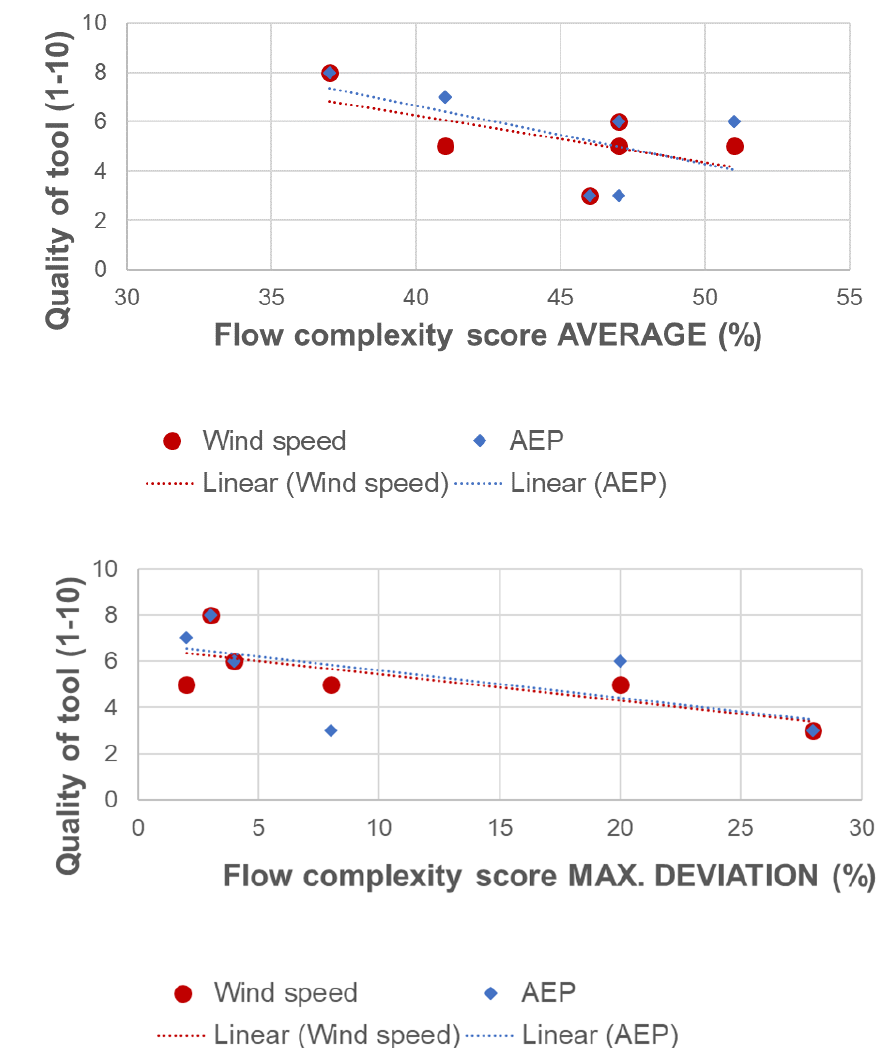
Figure 6. Quality of tool vs. flow complexity score average ( top ) and standard deviation ( bottom ) for all five sites (wind speed in red, AEP in